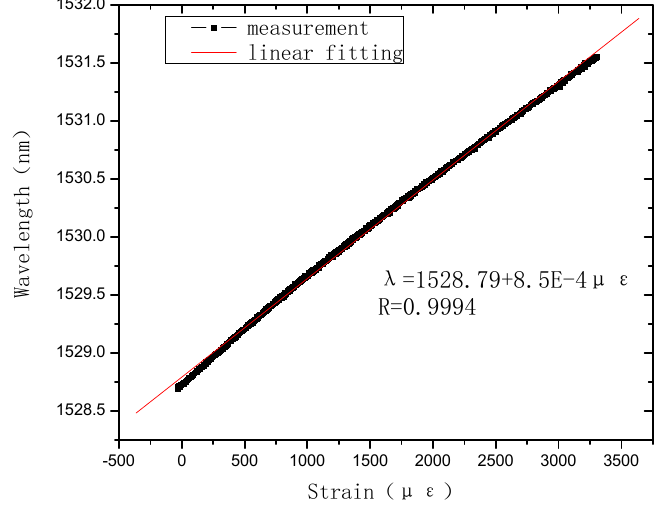
Figure 11. Strain sensing properties of PP-OFBG sensor.